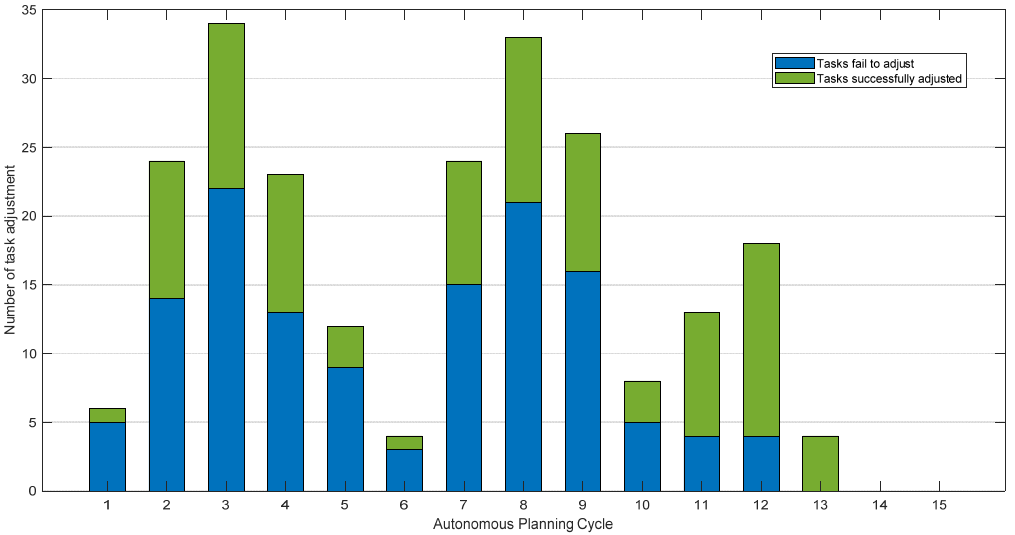
Figure 5. Task adjustments during each autonomous planning cycle.